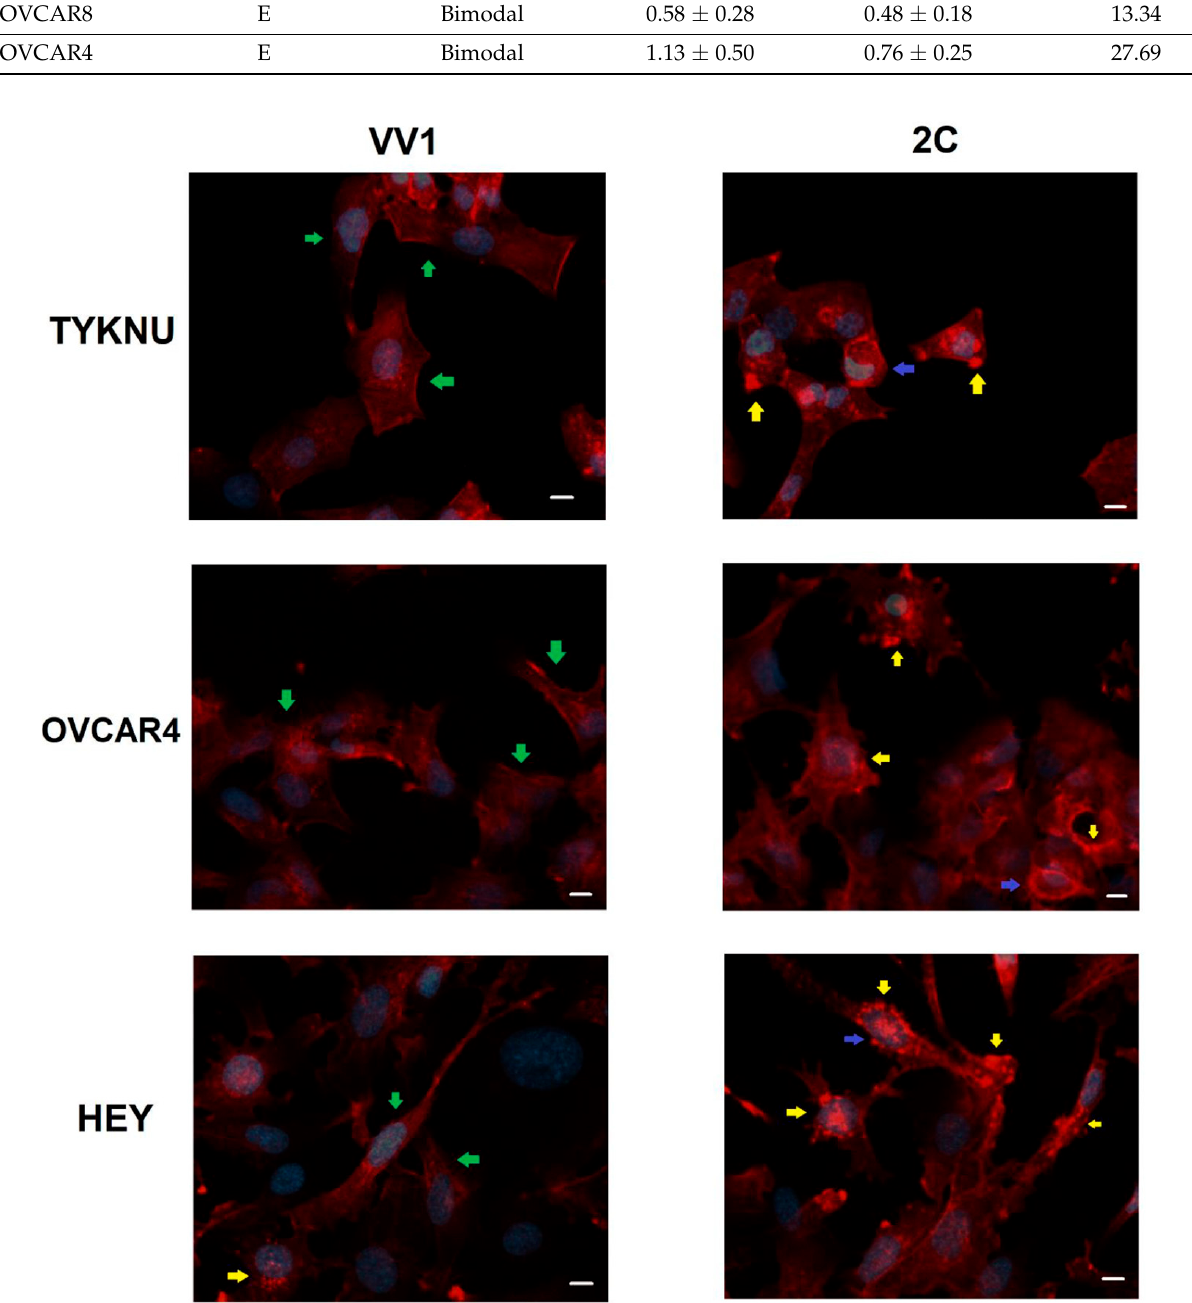
Figure A1. Images of F-actin immunofluorescence staining by phalloidin for TYKNU, OVCAR4 and HEY cell lines treated with VV1 (negative control) and 2c. In blue, the DAPI-marked nuclei. Green arrows: stress actin fibers; Yellow arrows: high-intensity spots; Blue arrows: high-intensity rings. Scale bar = 10 μ m.